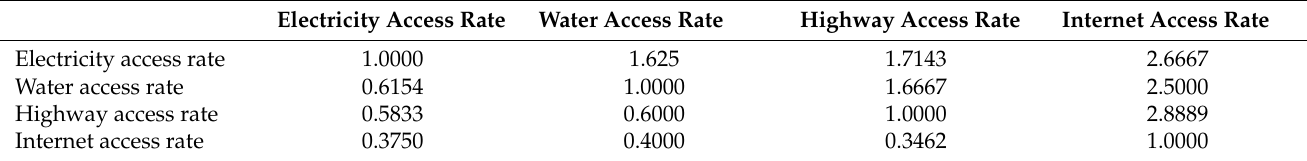
Table A6. C2–D: Judgement matrix of the forest area construction.